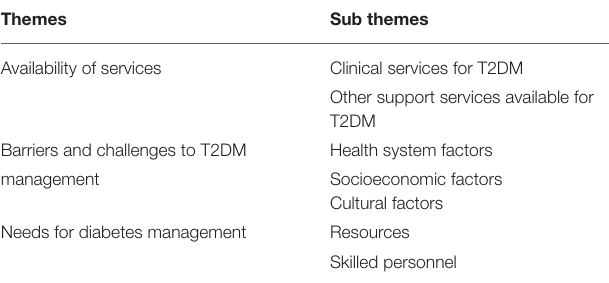
TABLE 1 | Demographic data of FGD participants ( n = 9). Variable